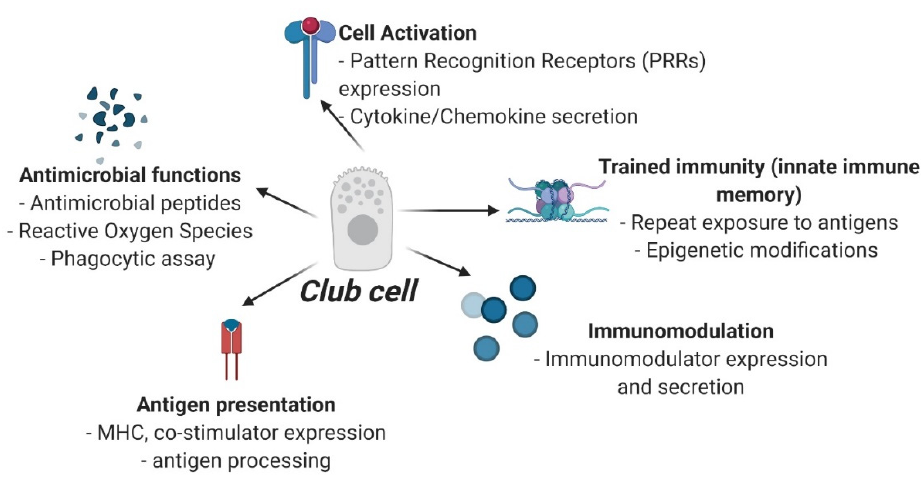
Figure 2. Proposed experiments for in-depth characterization of club cell’s immune function. Schematic created using www.biorender.com .